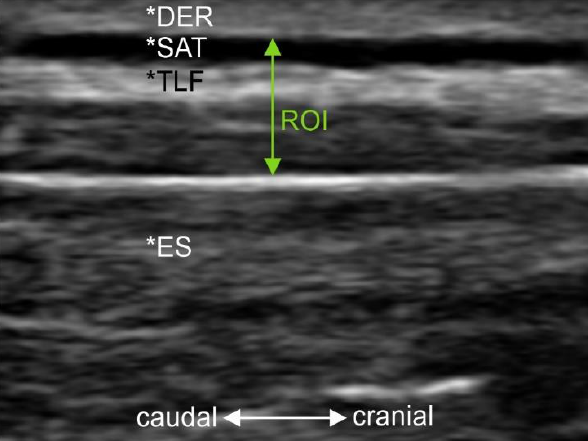
Figure 1. Anatomical orientation and delineation of the zones rated. *DER, dermis; *SAT, subcuta- neous adipose tissue; *TFL, thoracolumbar fascia; *ES, erector spinae muscle; ROI, region of interest, zones rated.